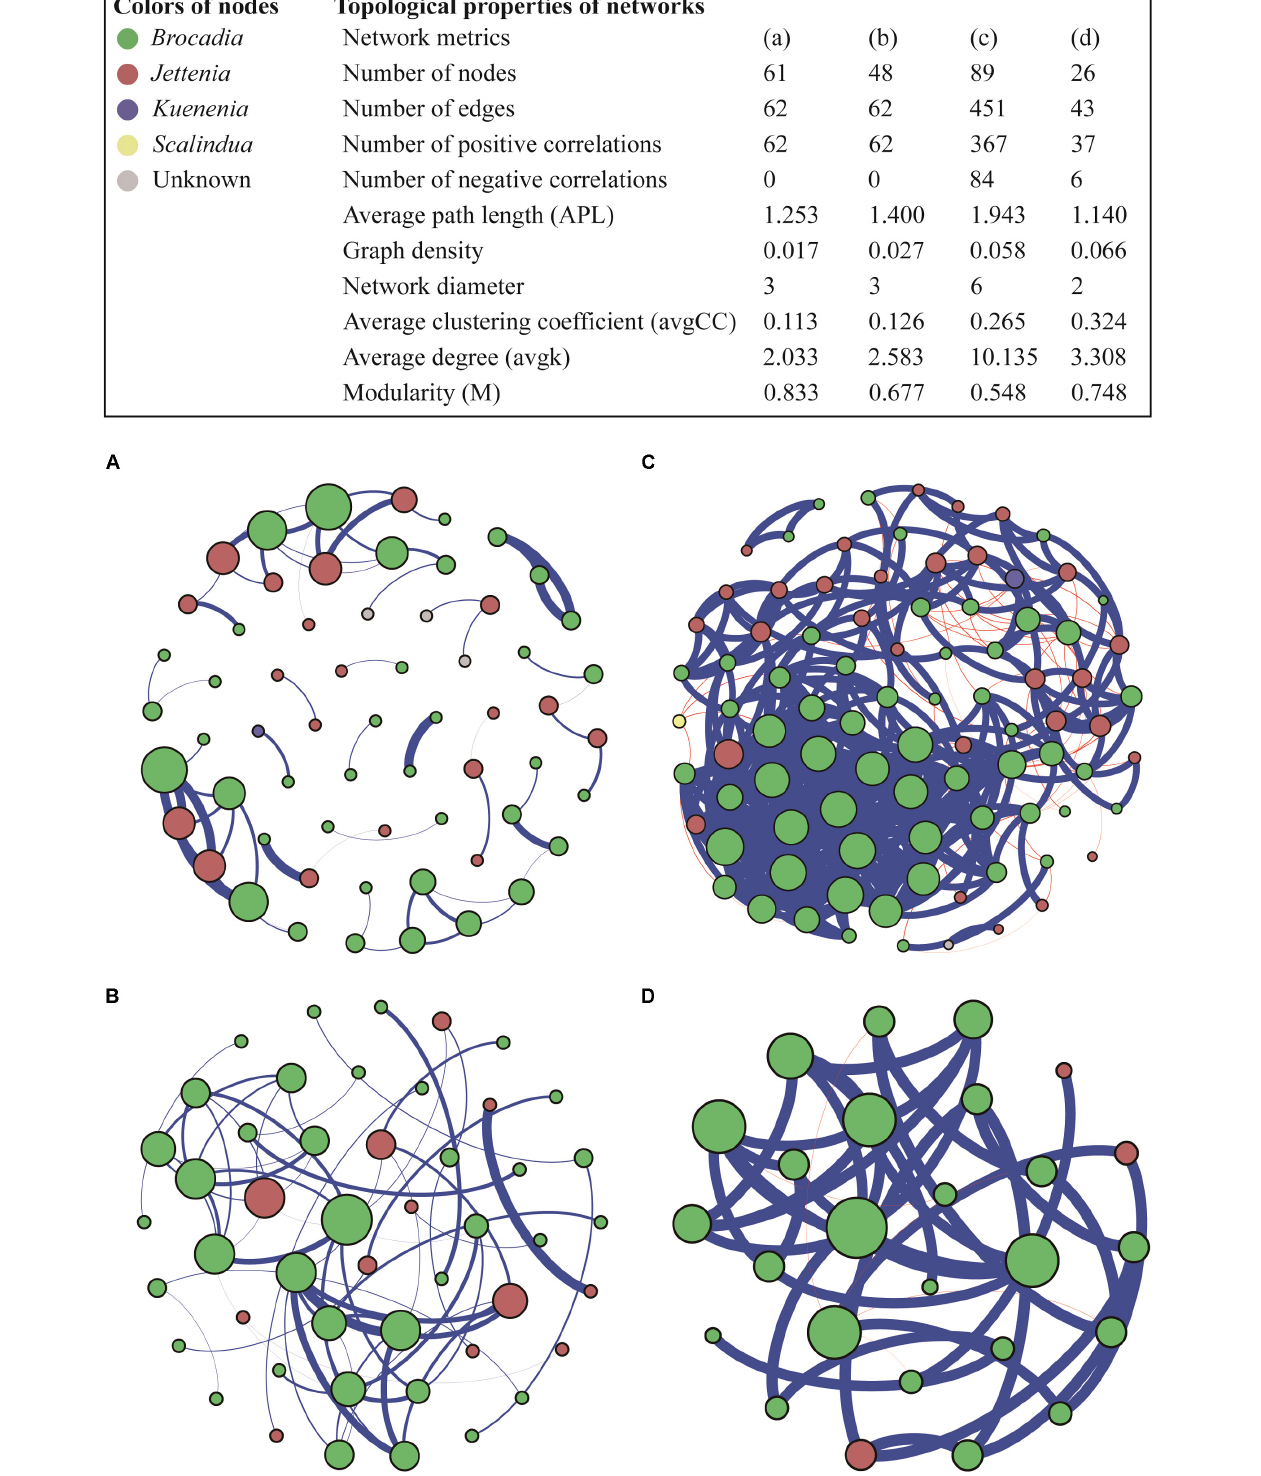
Frontiers in Microbiology |